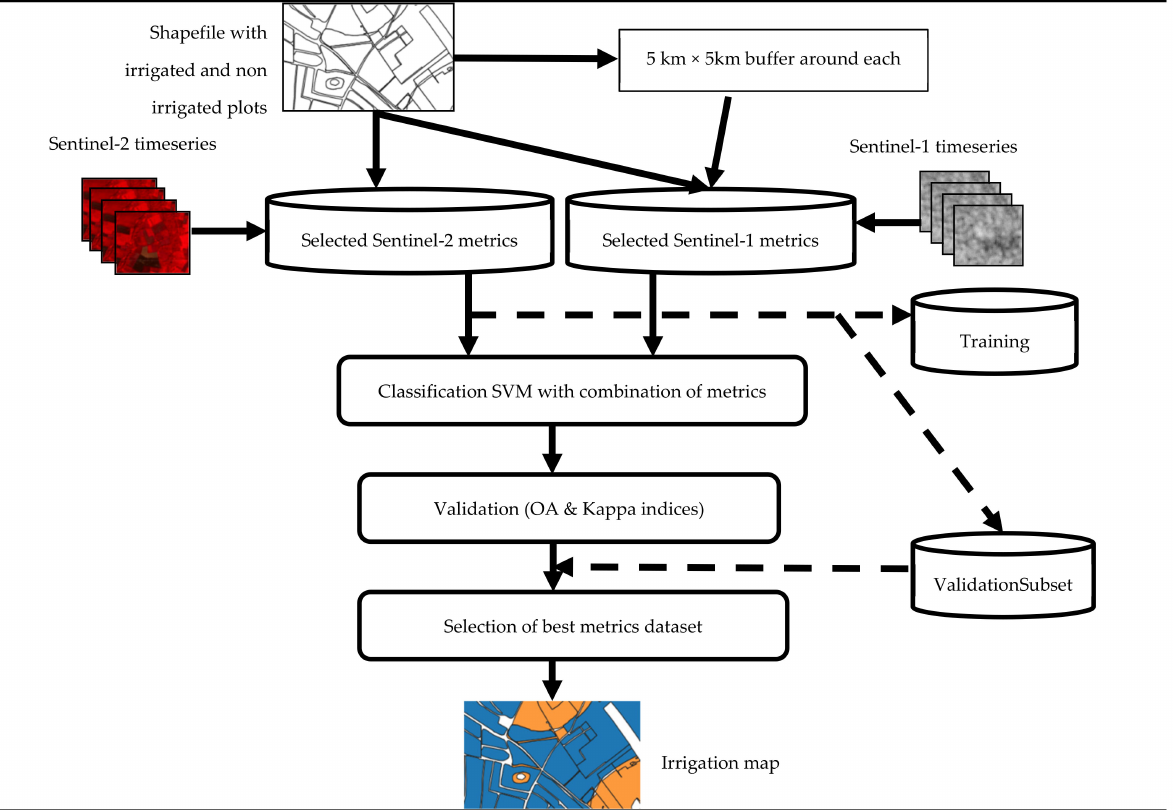
Figure 3. Image-processing workflow applied to a combination of Sentinel-1 and Sentinel-2